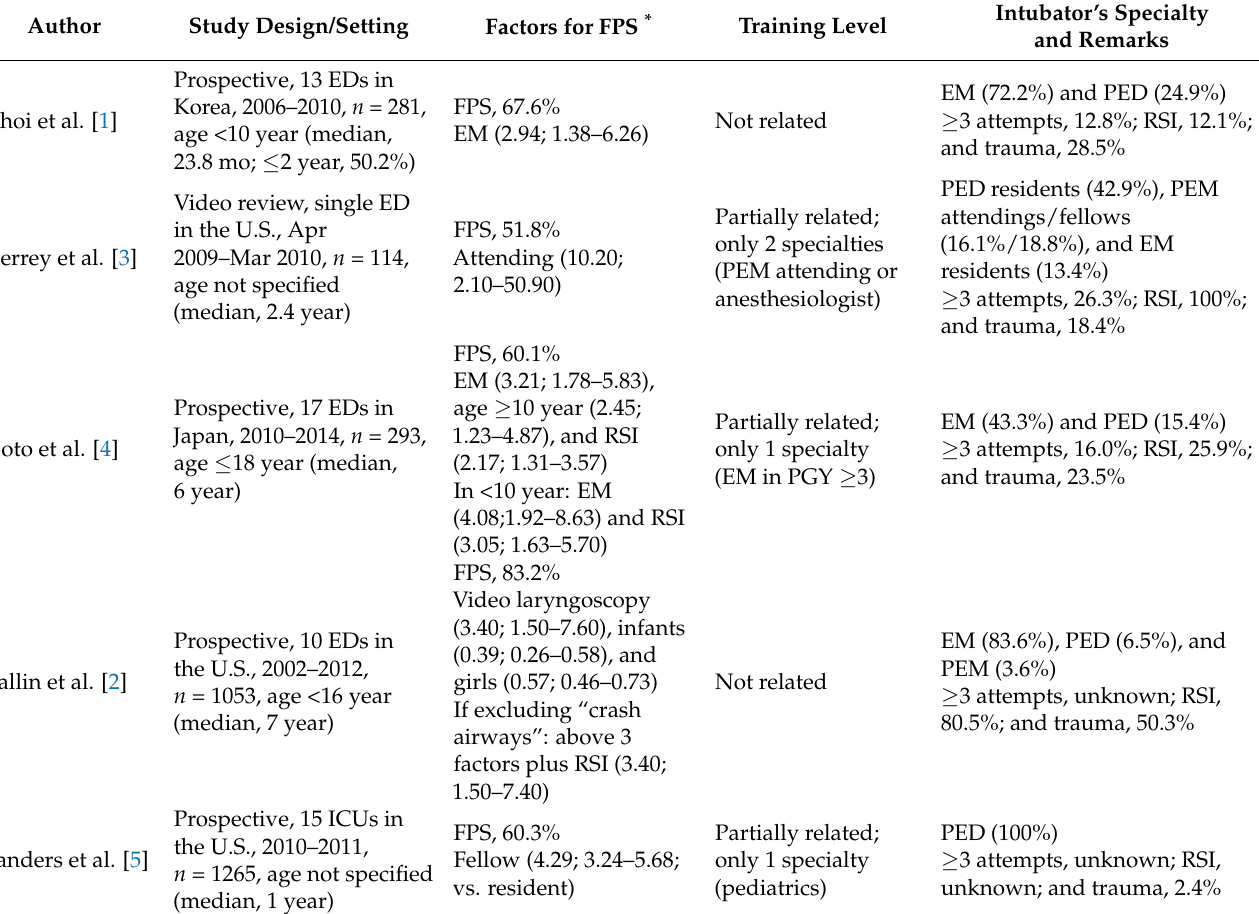
Table 1. Literature on factors associated with FPS of intubation in acute care